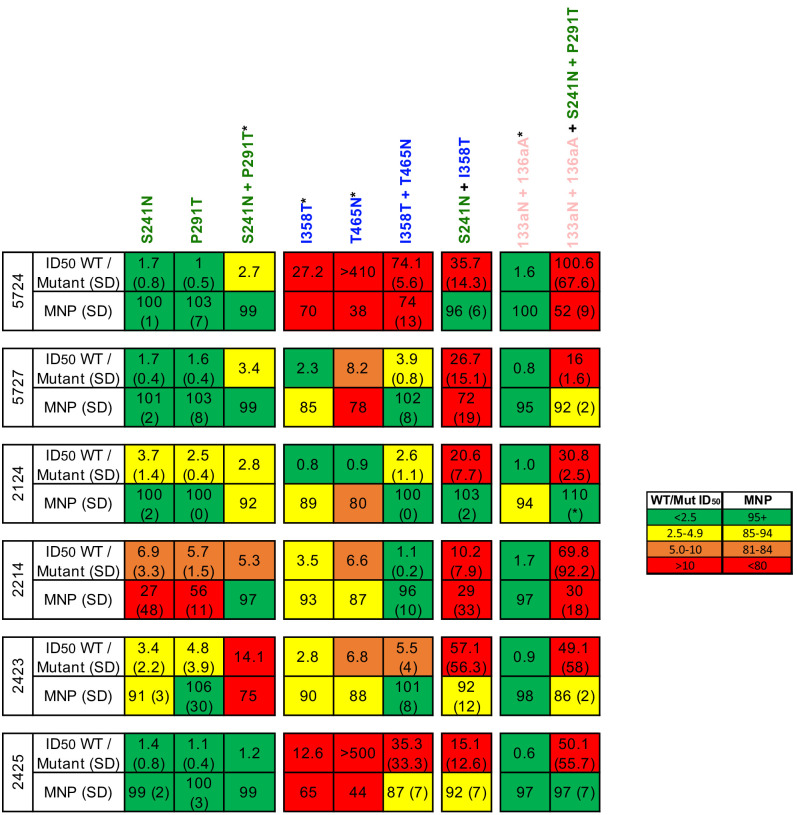
Effect of mutations that disrupt the C3/V5, glycan hole, and V1 epitopes alone and in combination with other epitope knockouts.Mutations are colored according to epitope, as in Figure 3. The standard deviation of replicate measures is shown in parentheses. Mutants labeled with an (*) are from the preliminary point-mutant mapping in Figure 1A; these experiments were performed in a different lab than the remainder of TZM-bl point-mutant mapping. While fold change in ID50 was always compared to a wild-type virus ran in parallel in independent labs, results across labs should only be interpreted generally (as presented in Figure 3C).